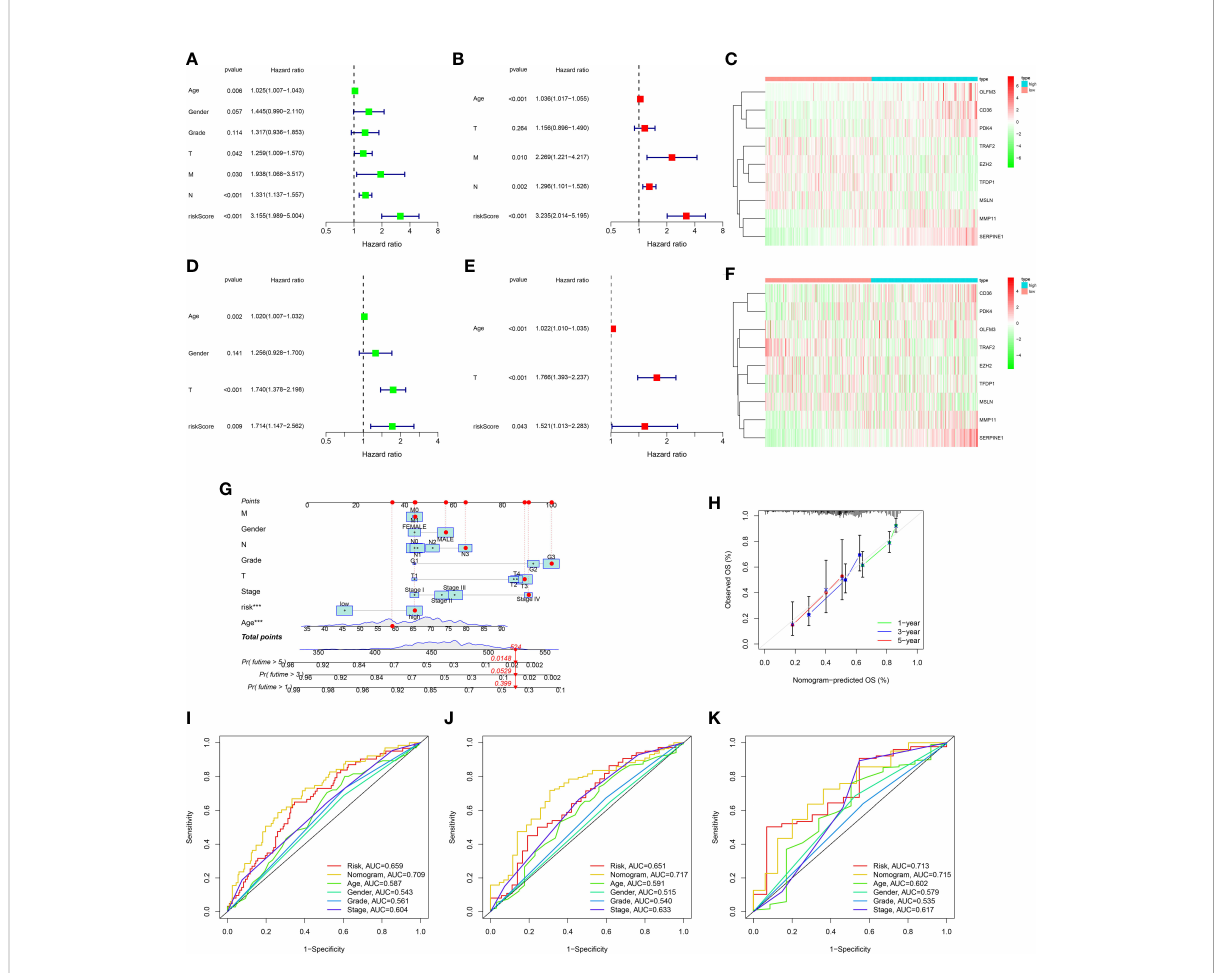
FIGURE 5 Construction and assessment of nomogram. (A) Univariate Cox regression analysis of the ARGs signature and clinical characteristics in the TCGA dataset. (B) Multivariate Cox regression analysis of the ARGs signature and clinical characteristics in the TCGA dataset. (C) The gene expression levels of ARGs signature in the high and low risk groups of the TCGA dataset. (D) Univariate Cox regression analysis of the ARGs signature and clinical characteristics in the GEO dataset. (E) Multivariate Cox regression analysis of the ARGs signature and clinical characteristics in the GEO dataset. (F) The gene expression levels of ARGs signature in the high and low risk groups of the GEO dataset. (G) The prediction of nomogram in the TCGA dataset. (H) Calibration plots for the nomogram. (I – K) Multifactor ROC curve for 1 year, 3 years and 5